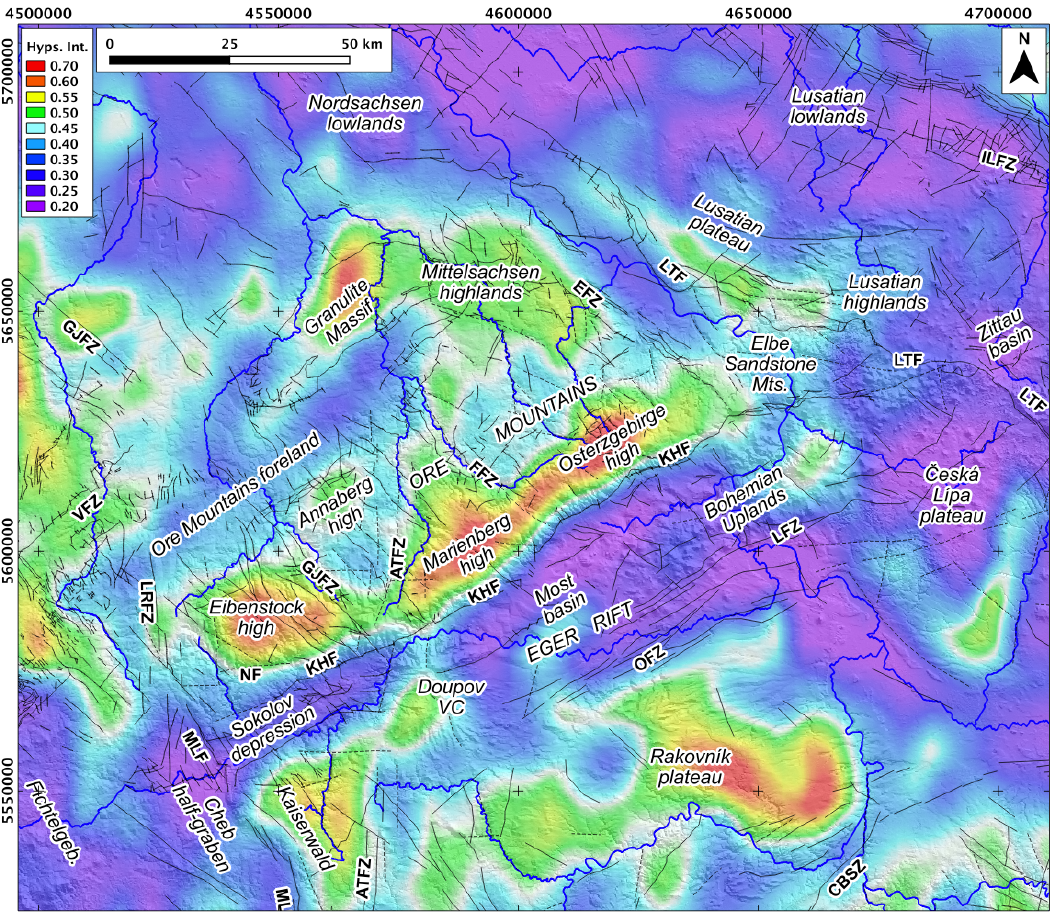
Figure 9. Hypsometric integral calculated using a 100-pixel moving window. Values above 0.5 highlight elevated surfaces. See Figure 2 for